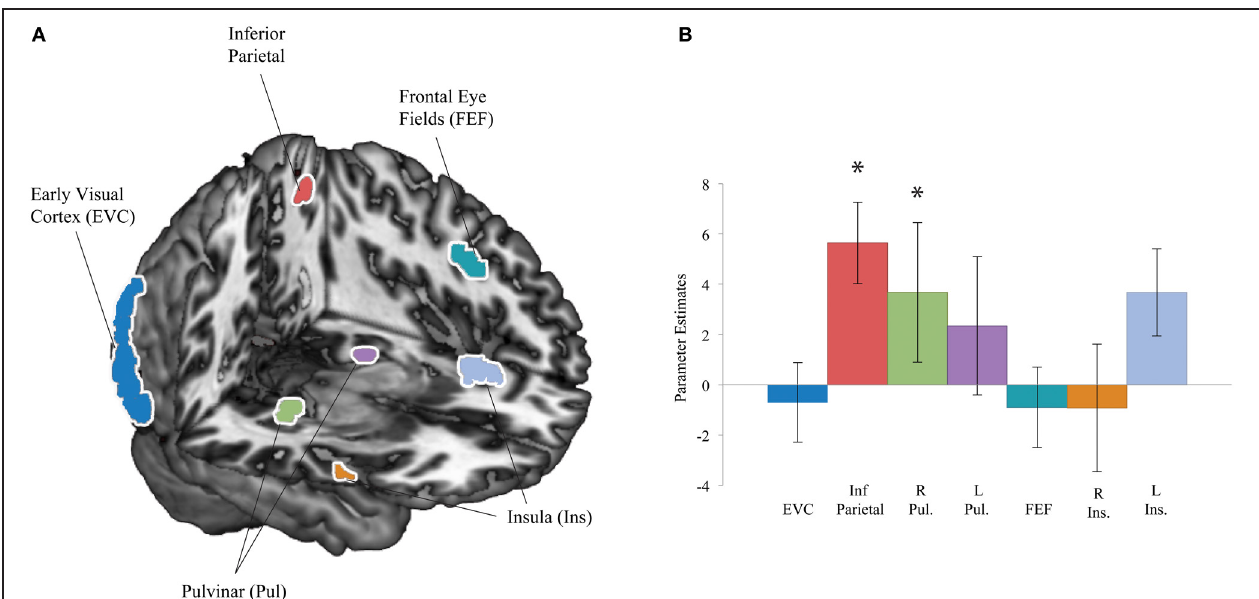
fields (FEF), and bilateral insula (Ins) (Troiani et al., 2012). (B) Region of interest results from a psychophysiological interaction (PPI) analysis with a right superficial amygdala seed. Significant effects were observed in left inferior parietal cortex (red) and the right pulvinar (green). ∗ p < 0 .